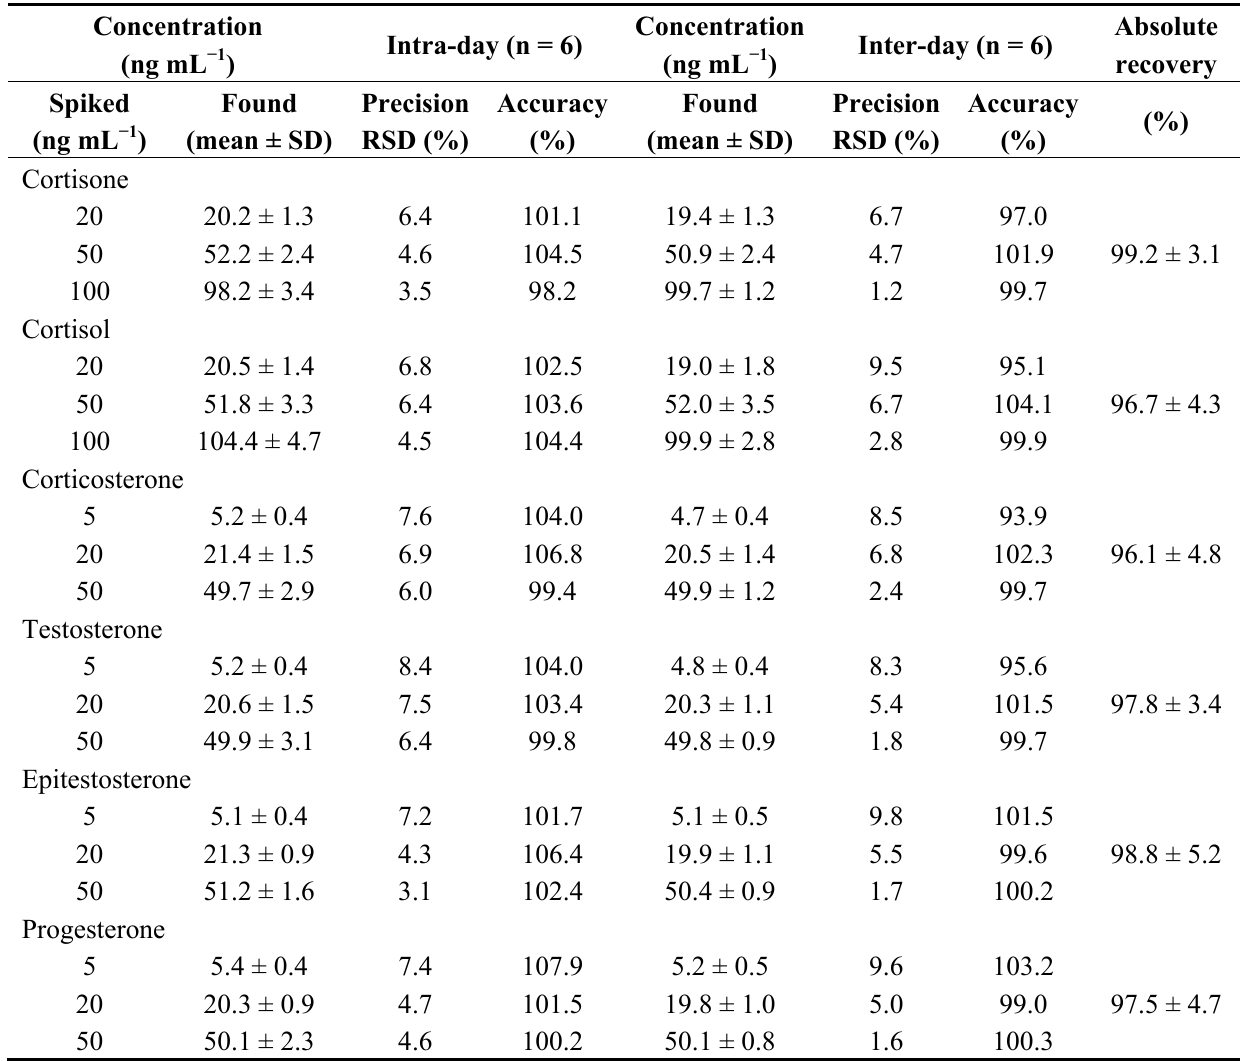
Table 2. Intra-day and inter-day precision and accuracy for the LC determination of six steroid hormones in urine